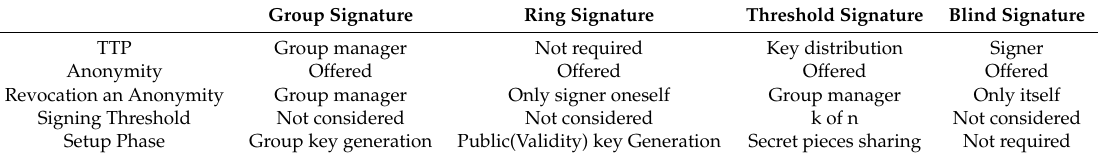
Table 3. A comparison of the features of anonymous digital signatures.